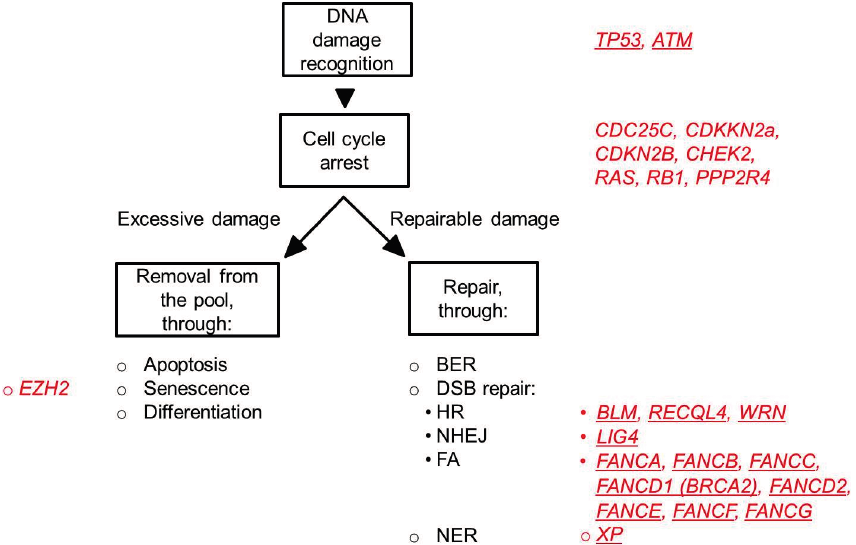
Figure 2. Cellular response to DNA damage. Depicted are the major cellular processes (in black letters) that are initiated after DNA damage. In red are the genes indicated that are symbols indicate genes that are perturbed in hereditary syndromes associated with a high risk of developing MDS (see also Table 1). MDS-associated perturbations in TP53 can be both inherited (Li-Fraumeni syndrome) as well as